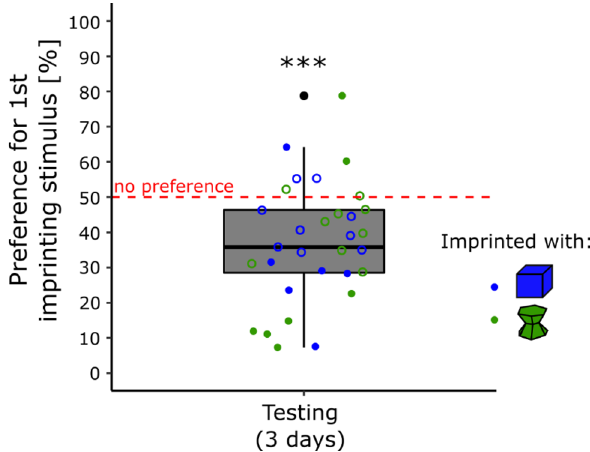
Figure 4. In experiment 4, chicks of both conditions had a preference for the secondary imprinting objects (p < 0.001, ***). The blue dots represent the preference score of the chicks imprinted with the blue stimulus. The green dots represent the preference score of the chicks imprinted with the green stimulus. Filled dots show the individuals having a significant preference while empty dots show the individuals having no preference. The asterisks represent the overall significance of both conditions pooled, against no